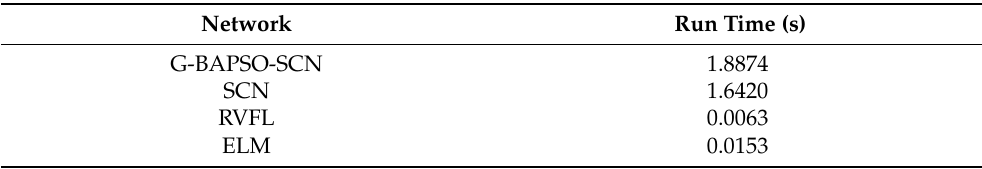
Table 12. The comparison of run time based on Dataset